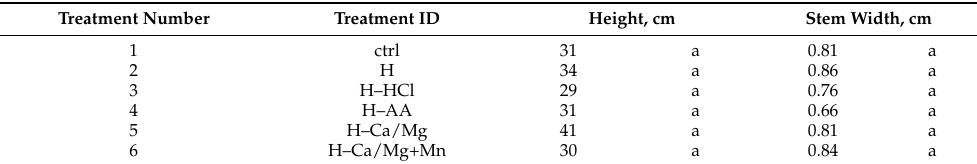
Table 4. Soybean height and stem width at 32 d (growth stage V8+) after planting for a hydroponic nutrition study.